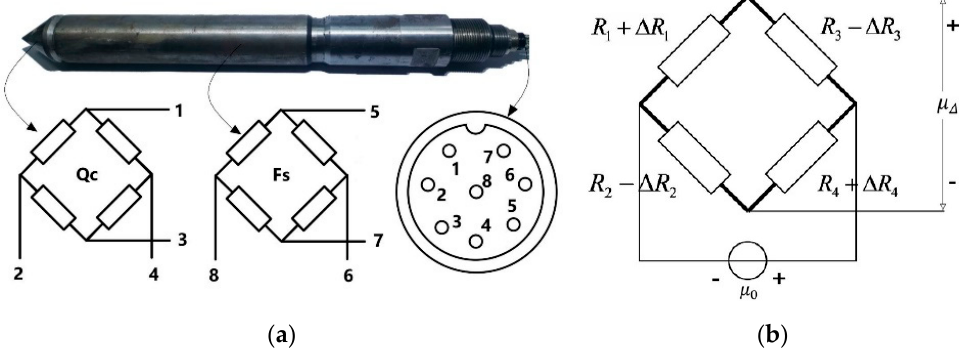
Figure 4. Sensor layout and electrical interface of the CPT probe. ( a ) sensor location and interface; ( b ) bridge circuit diagram.